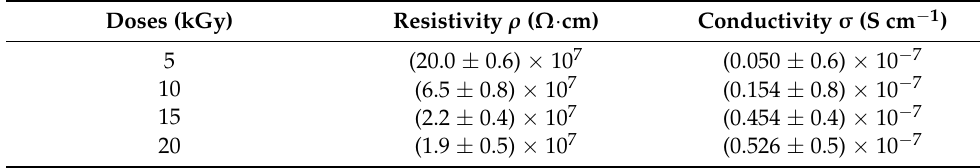
Table 1. Electrical resistivity and conductivity of the H 3 PO 4 75 v% polymer film sample. Doses